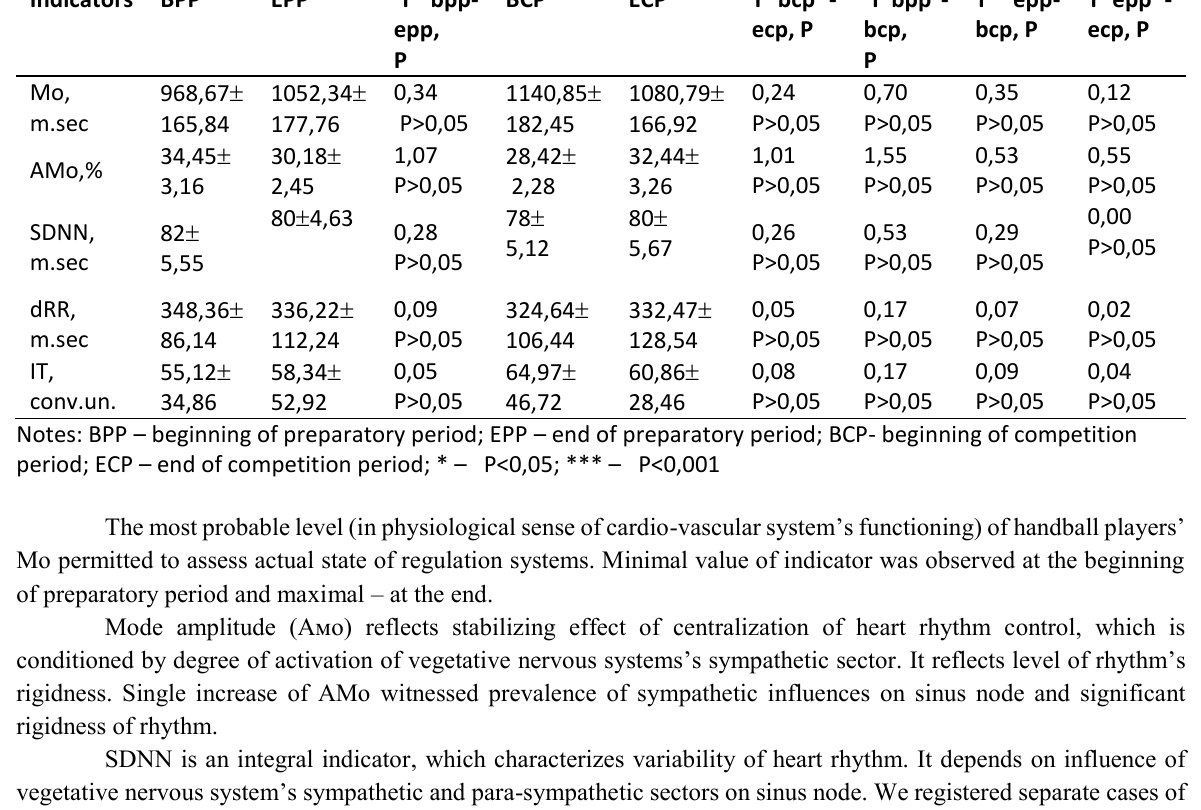
Table 1. Indicators of vegetative regulation of elite handball players at different stages of the research (Х  m)